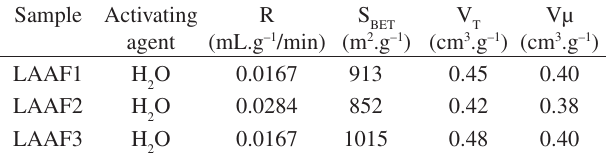
Table 3. Compared data for physically activated carbons. Sample Activating